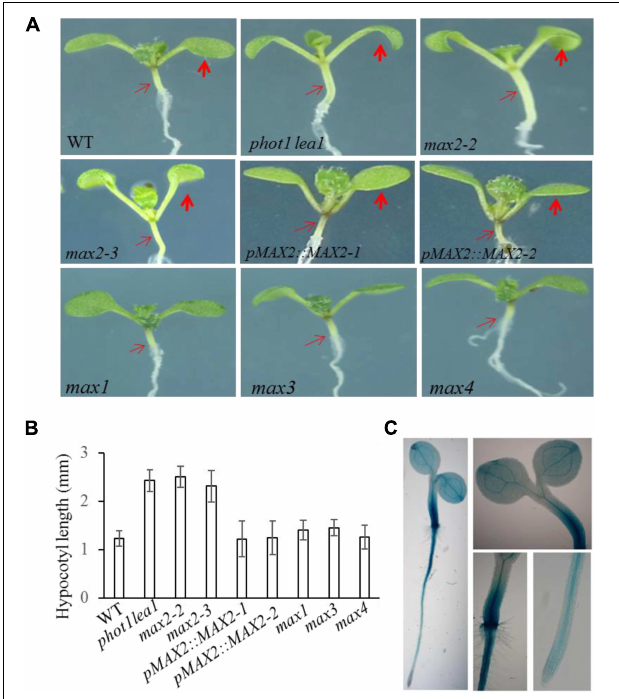
FIGURE 3 | Hypocotyl elongation of WT, phot1 lea1 , and the max mutants. (A) Hypocotyl elongation of WT, phot1 lea1 , max mutants, and transgenic plants ( phot1 lea1 plants with complemented MAX2 expression driven by the native promoter). The bold red arrows indicate the cotyledons, while the fine red arrows indicate the hypocotyls. (B) Hypocotyl length of seedlings represented in panel (A) . Each bar represents an average of three experiments (15–20 measurements in each experiment) ± SE. (C) Tissue localization of MAX2 expression. GUS staining of transgenic plants revealed the MAX2 expression in the roots, leaves, and hypocotyl.